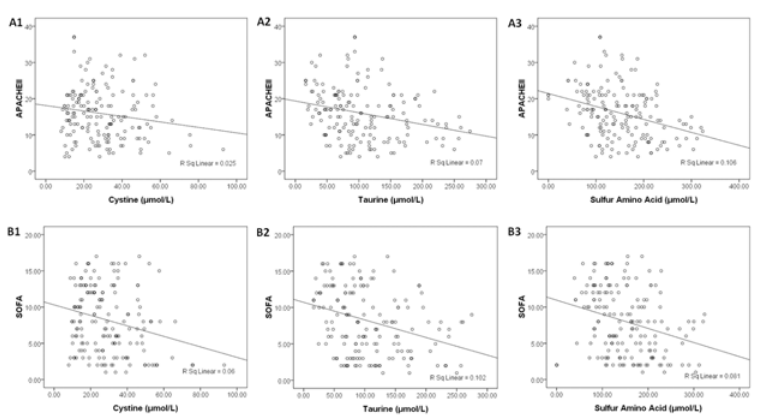
Fig 4. The relationships between the APACHE II (A) and SOFA (B) scoring systems and the serum concentrations of cystine (1), taurine (2), and sulfur-containing amino acids (3) at all time points post-